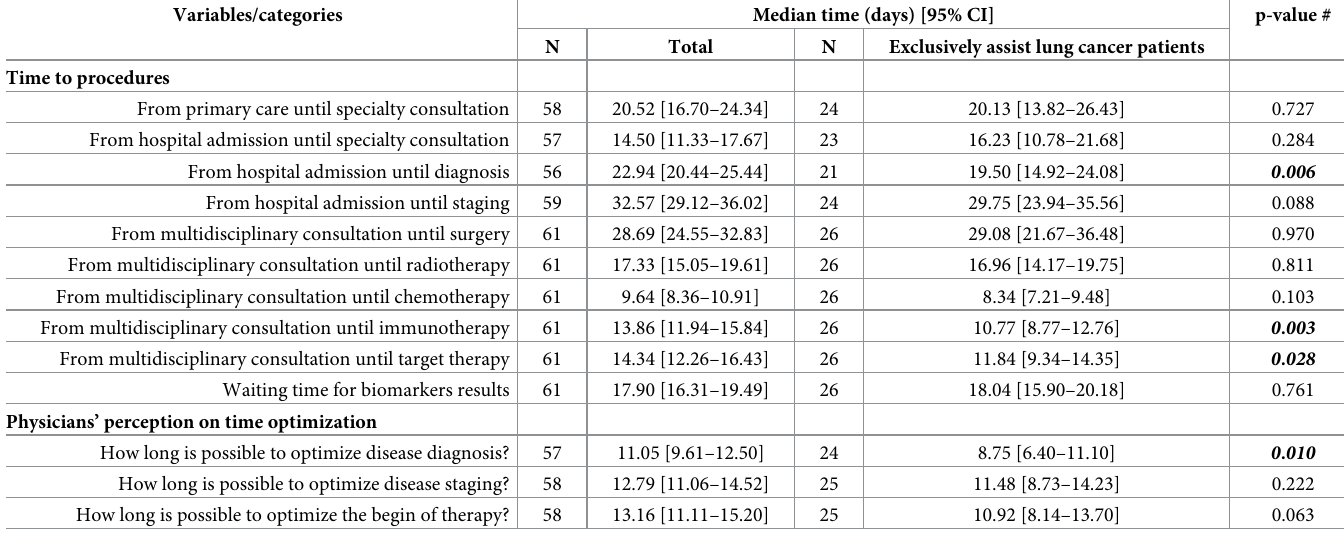
Table 3. Time lags to diagnosing lung cancer in